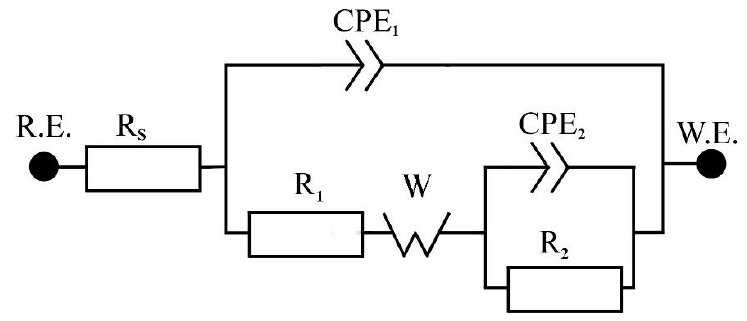
Figure 7. Schematic of EC used for modelling of EIS spectra for all samples.